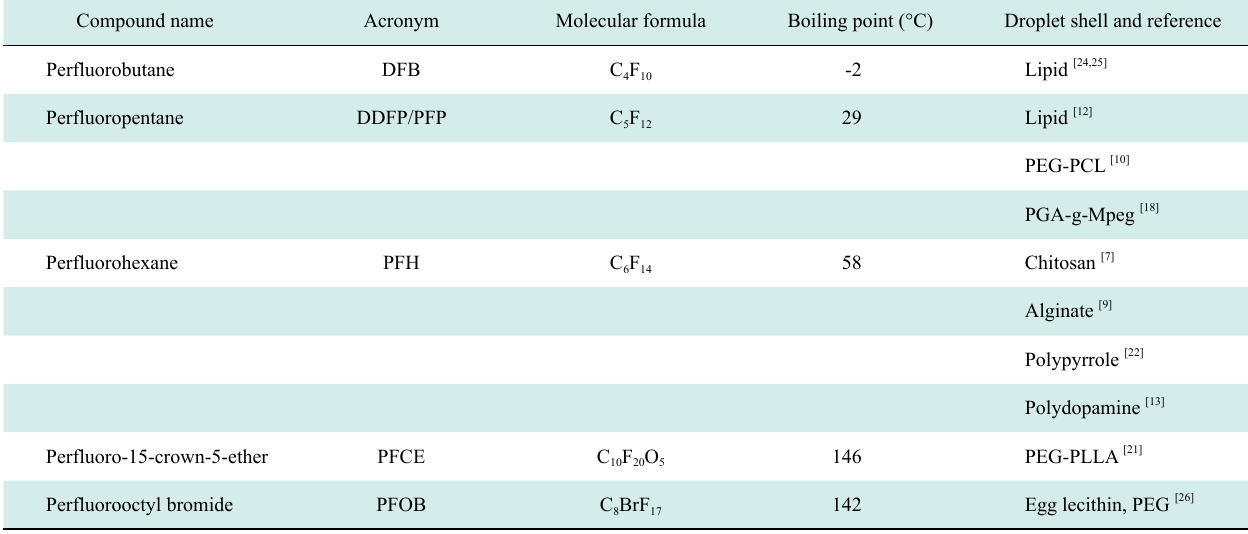
Table 1 Properties of commonly used PFCs for fabrication of